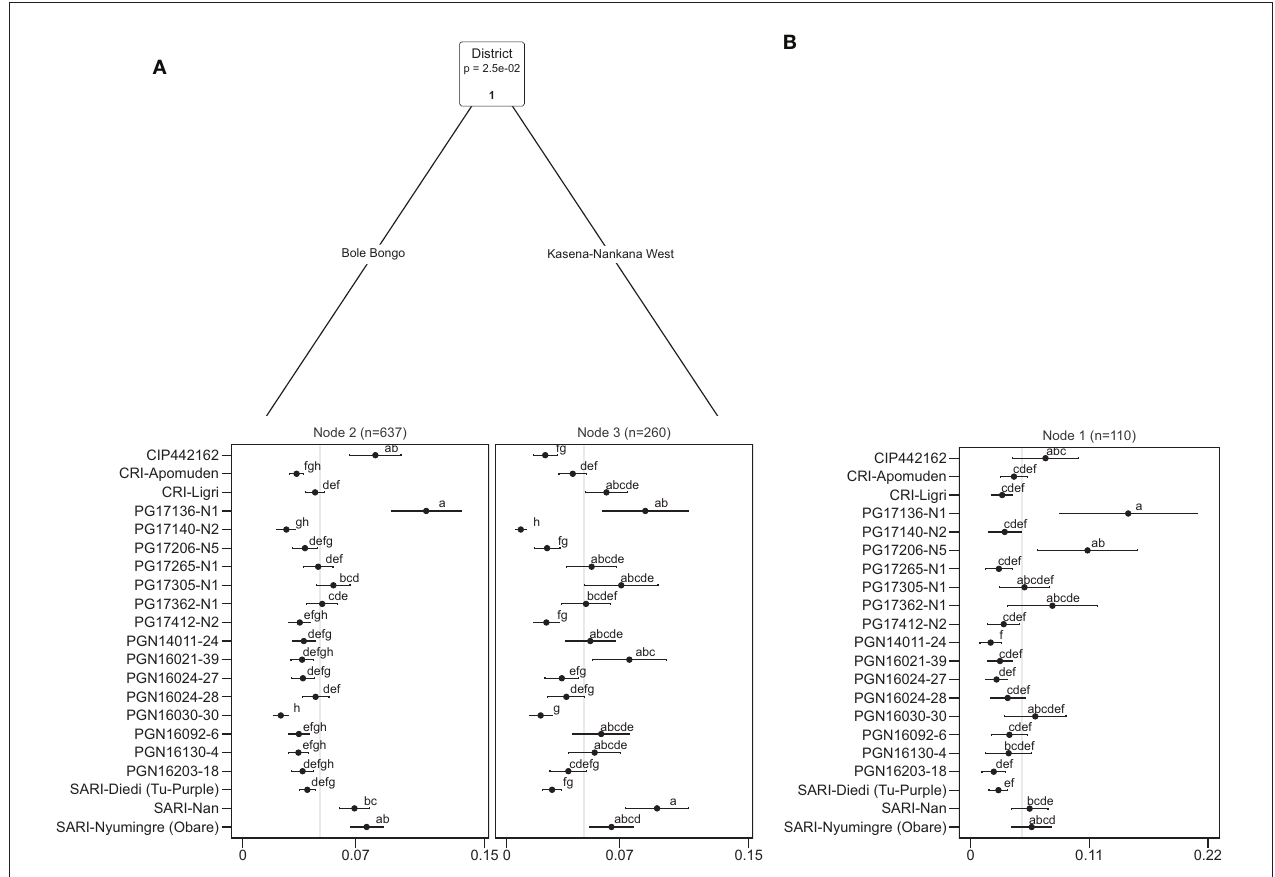
FIGURE 7 | Plackett-Luce Tree of crowdsourcing citizen-science evaluation on sweetpotato genotypes in (A) centralized tasting and (B) home tasting in Ghana. The horizontal axis of each panel represents the probability of winning for the genotypes. Error bars show quasi-SEs. The gray vertical line indicates the average probability of winning (1/number of genotypes). In this case, the model selected the district as the splitting covariate. Different letters indicate significant differences at p < 0.1.